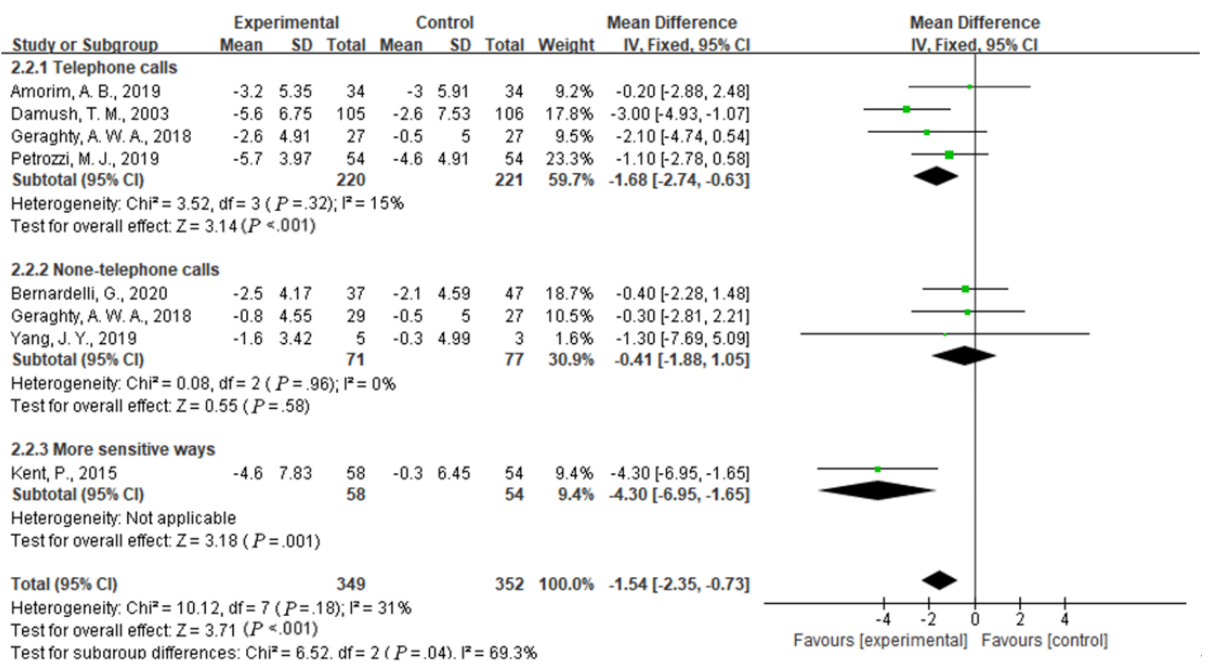
Figure 6. Efficacy of telephone use and the more sensitive feedback intervention in reducing